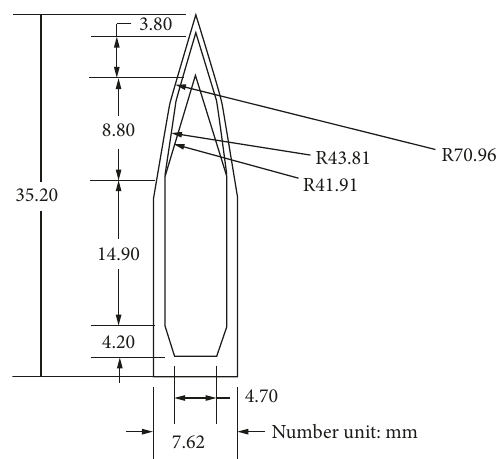
Figure 4: 0.30 ″ AP bullet dimensions. Table 2: Mechanical properties of material model 3